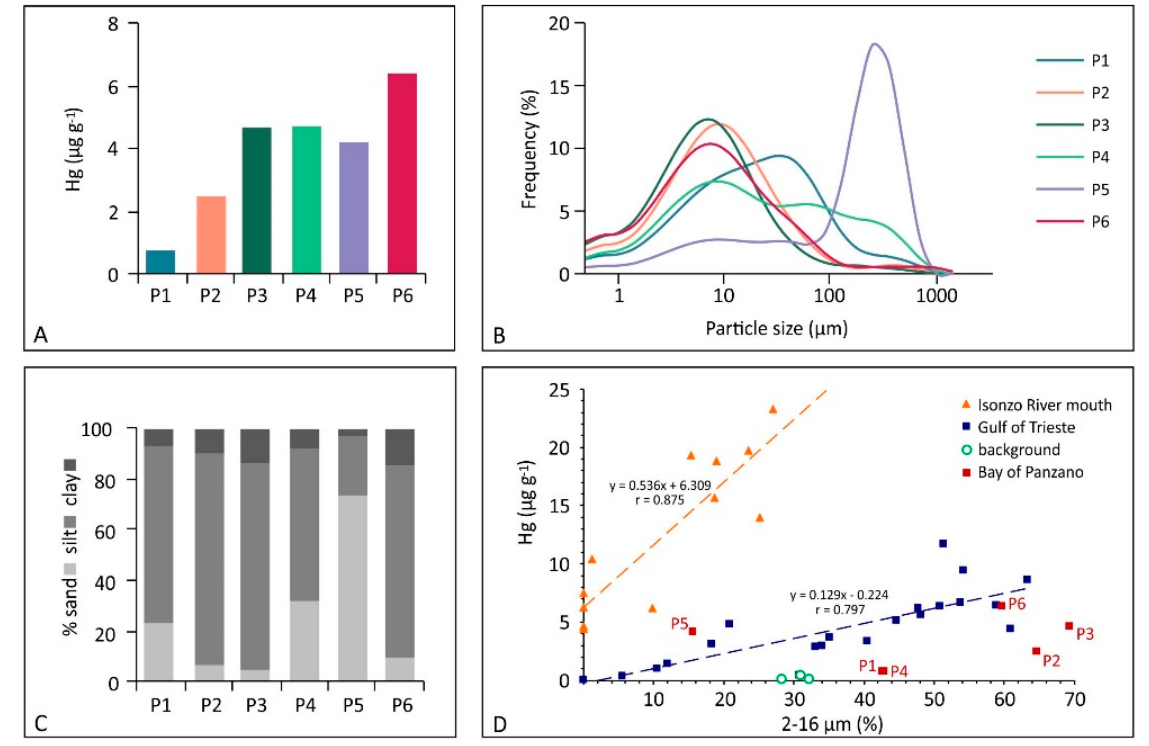
Figure 3. ( A ) Concentration of Hg (µg g − 1 ) in the surface sediments collected at the six investigated sites (P1–P6) in the Bay of Panzano; ( B ) Grain size spectra of the sediment samples; ( C ) Grain size composition of the sediment samples; ( D ) Relationship between Hg concentration in the surface sediments and the 2–16 µm grain size fraction (modified and redrawn from [19]). Table 2. Ranges of Hg concentration in surface sediments from this study compared to local areas of the Gulf of Trieste and other similar environments in the world as reported in the